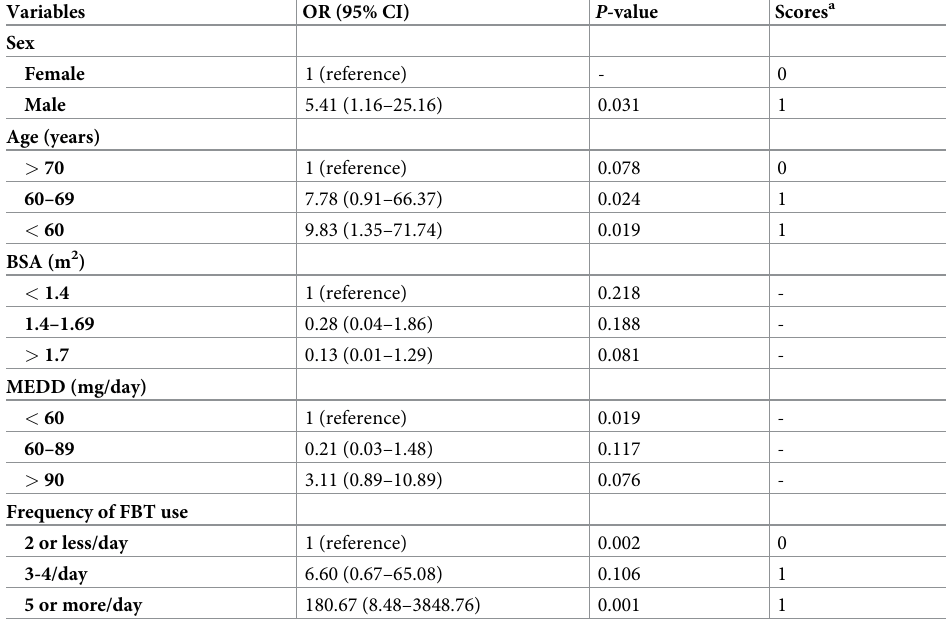
Table 3. Multivariable analysis for tolerability of fentanyl buccal tablet (FBT) 400 μ g or higher (final FBT, 400/ 800 μ g vs. 100/200 μ g). Variables